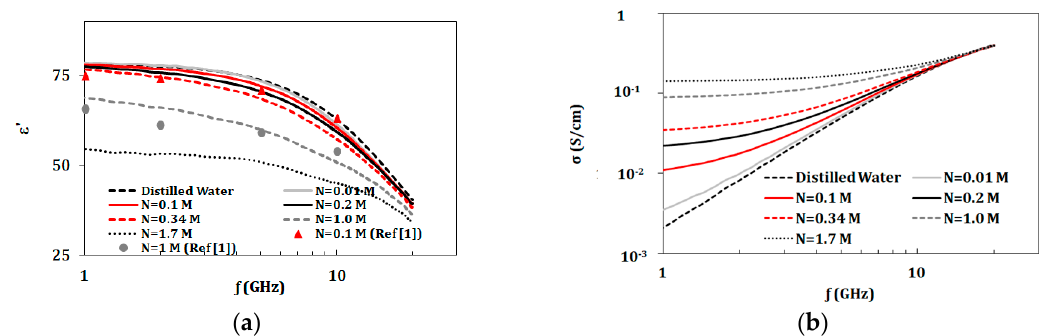
Figure 2. ( a ) Measured dielectric constant and ( b ) Measured conductivity for NaCl solutions at ion concentrations from 0.01 to 1.7 mol/L at temperature 23 °C in the range of 1–20 GHz (“N” refers to NaCl and “M” refers to mol/L).